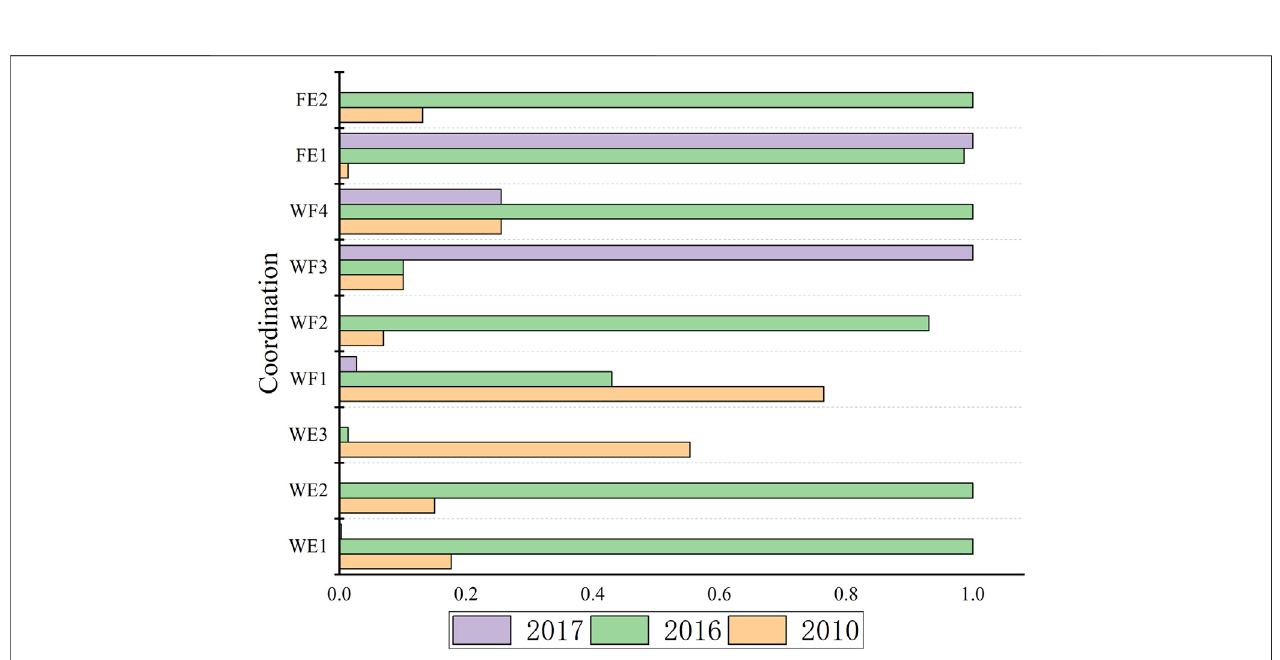
FIGURE 6 | Comparison of coordination indicator evaluation values in typical